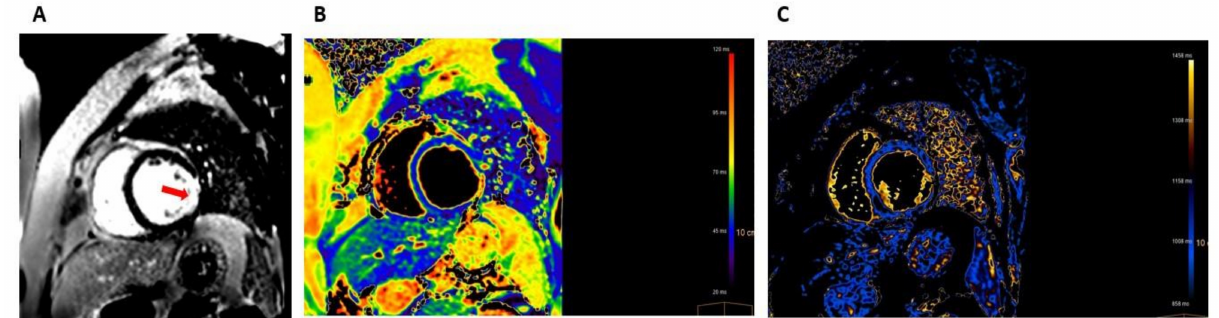
Figure 2. Cardiac MRI (1.5T) at presentation. ( A ) A short axis view of late gadolinium enhancement (LGE) image showing transmural LGE in the lateral and inferolateral wall (red arrow). ( B ) A T2 mapping image showing myocardial edema with regionally increased T2 values (78 milliseconds) in the lateral and inferolateral wall. ( C ) A T1 mapping image showing myocardial injury with increased native T1 values (1288 milliseconds) in the lateral and inferolateral walls.